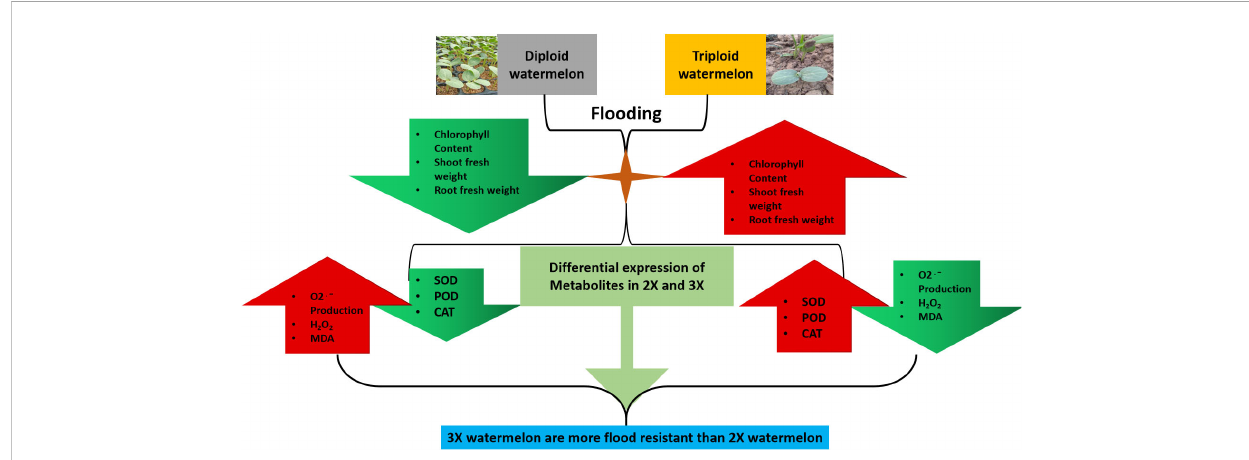
FIGURE 11 A schematic representation of overall phenological, physiological and biochemical variations among 2X and 3X watermelon leaves in response to fl ooding at different time